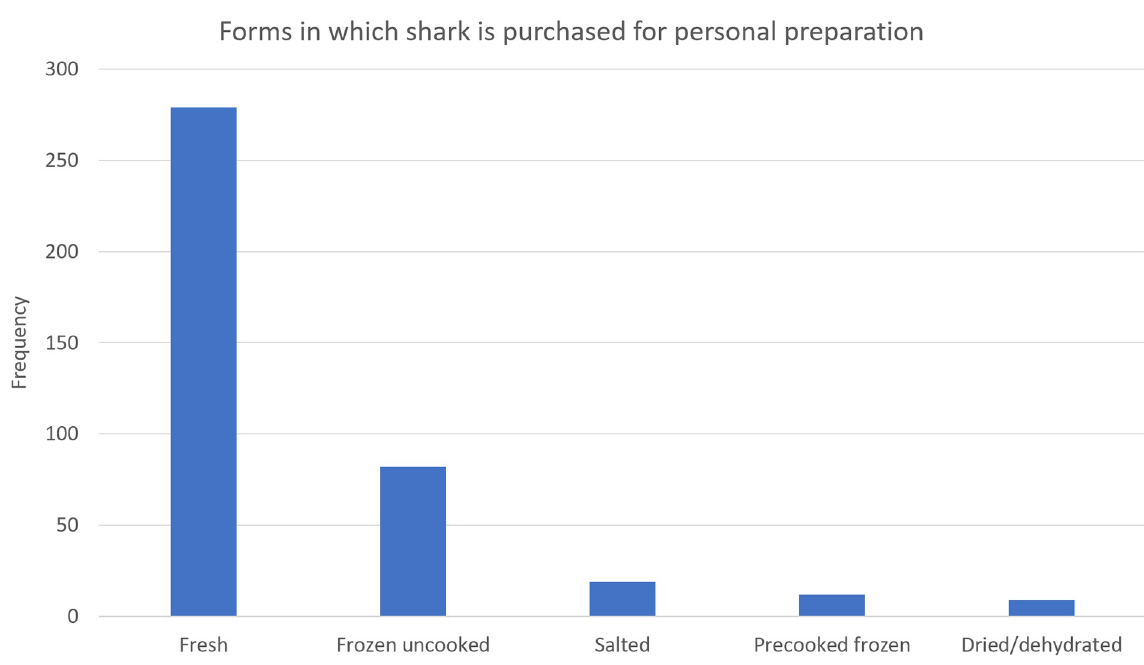
Fig 10. Popularity of various forms in which shark is purchased for personal preparation. (See S3 Appendix for